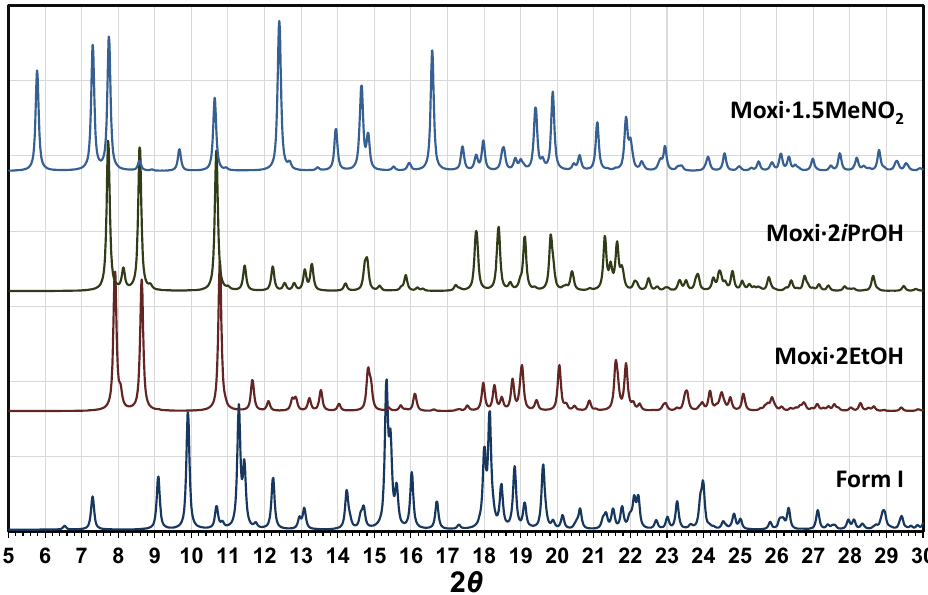
Figure 1. Calculated PXRD patterns (radiation Cu-K α ) for moxidectin known crystal forms: bottom to top: Form I; Moxi· 2 EtOH; Moxi· 2i PrOH; Moxi·1.5MeNO 2 . Patterns were calculated from single crystal XRD using the Mercury (CCDC) powder diffraction simulation tool.